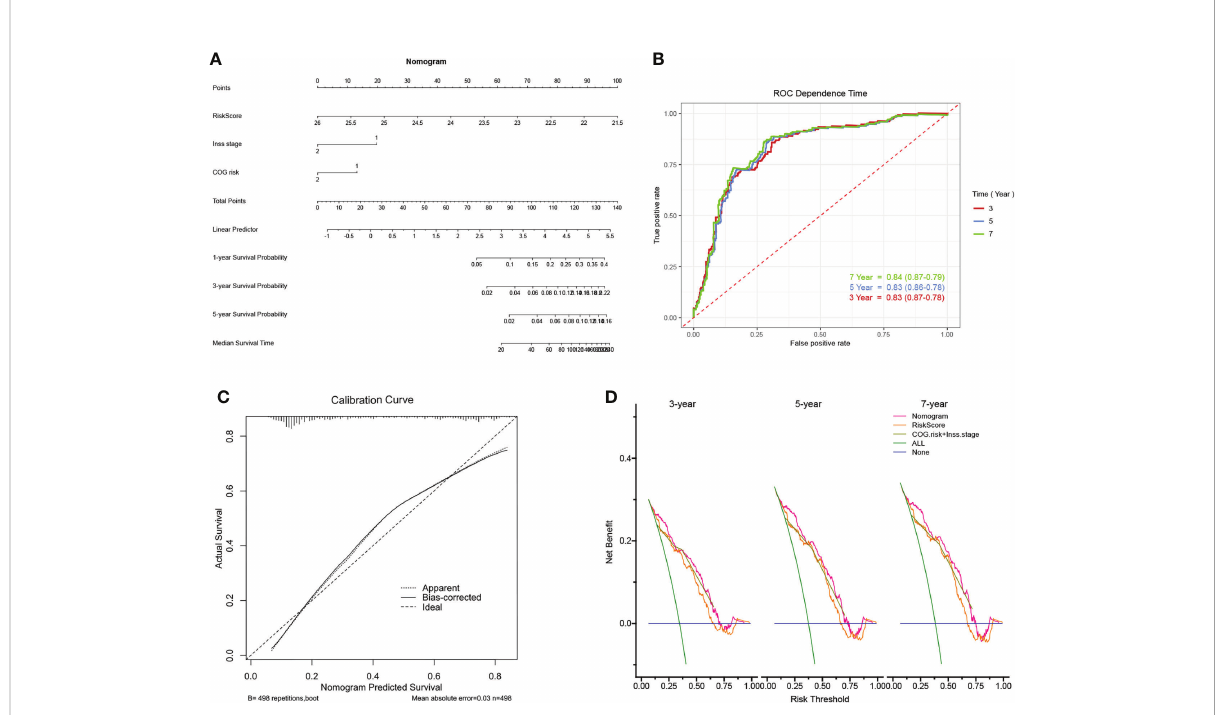
FIGURE 6 Construction of the nomogram and its accuracy veri fi cation. (A) The riskscore assessment nomogram to evaluate prognosis in NB (1-, 3-, and 5-year survival rates). (B) The time-dependent ROC curves were applied to assess the predictive performance of the nomogram, in 3-, 5-, and 7-year survival. (C) Calibration curves of the nomogram. (D) Net bene fi t (y-axis) as calculated are plotted against the threshold probabilities of patients having 3-, 5- and 7-year survival on the x-axis. The green line represents the assumption that all patients have indicated survival